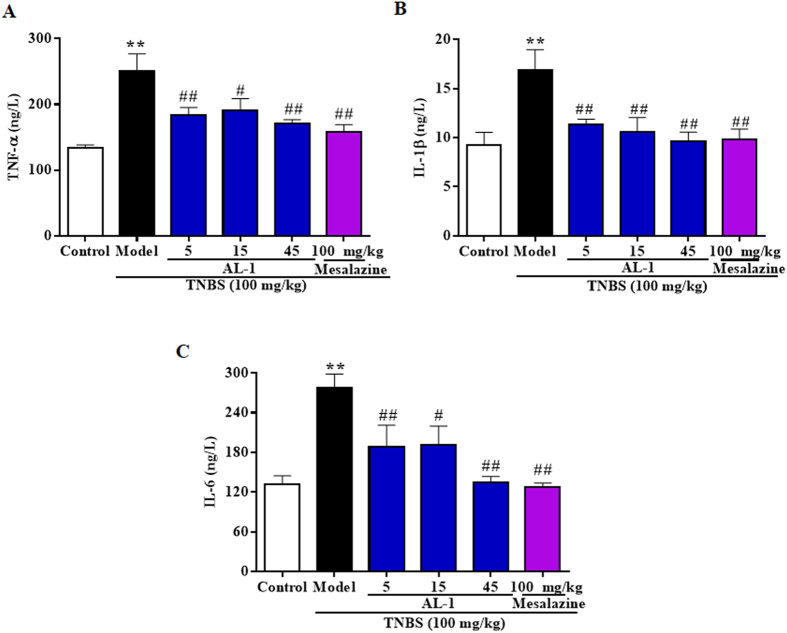
Inhibitory effects of AL-1 on the pro-inflammatory cytokine production in serum level of mice.The production of (A) TNF-α, (B) IL-1β and (C) IL-6, were assayed in colonic tissues of mice. Mice were challenged with solvent or TNBS at day 0 and treated with control, AL-1 (5, 15 and 45 mg/kg) or mesalazine (100 mg/kg) for days 0–3. The TNF-α, IL-1β and IL-6 concentration in the serum level were determined by ELISA. Values were shown as the means ± SEM, n = 8 for each group. **P < 0.01 vs control group, #P < 0.05 and ##P < 0.01 vs mice treated with TNBS alone.